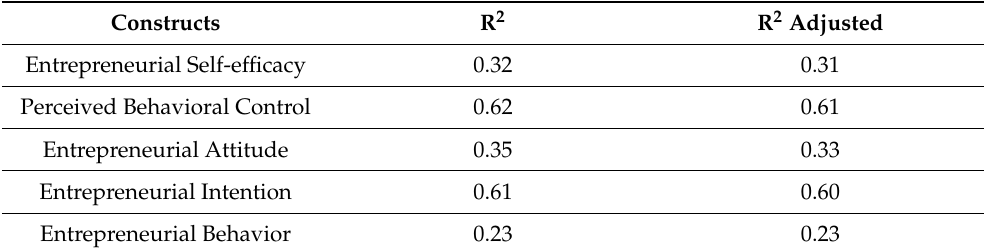
Table 3. Endogenous latent variable coefficient of determination (R 2